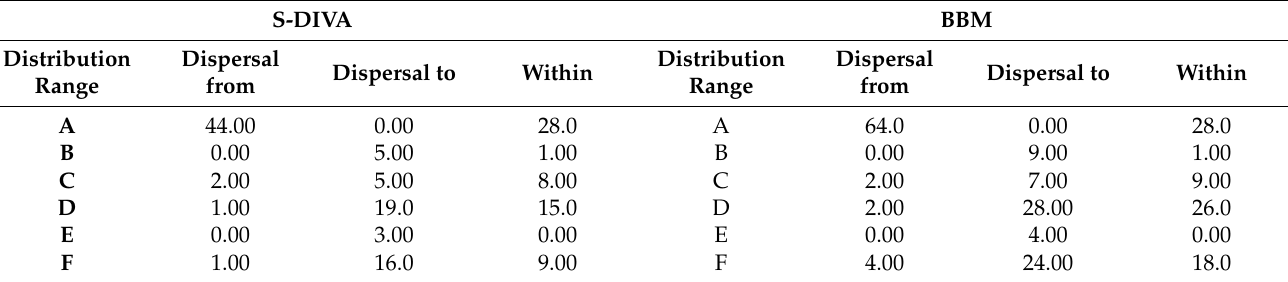
Table 3. Dispersal details of different distribution area based on S-DIVA and